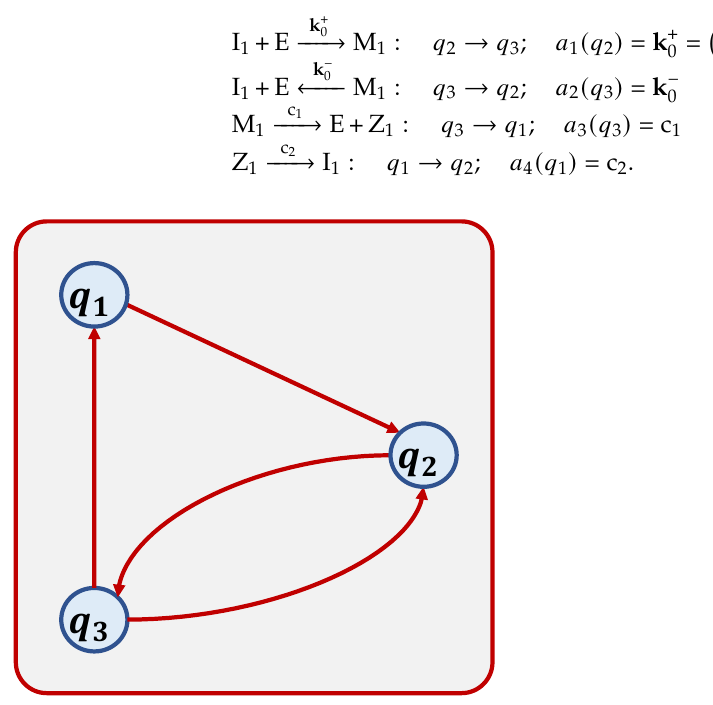
Figure A1. Transitions between microstates for the isolated SISO system